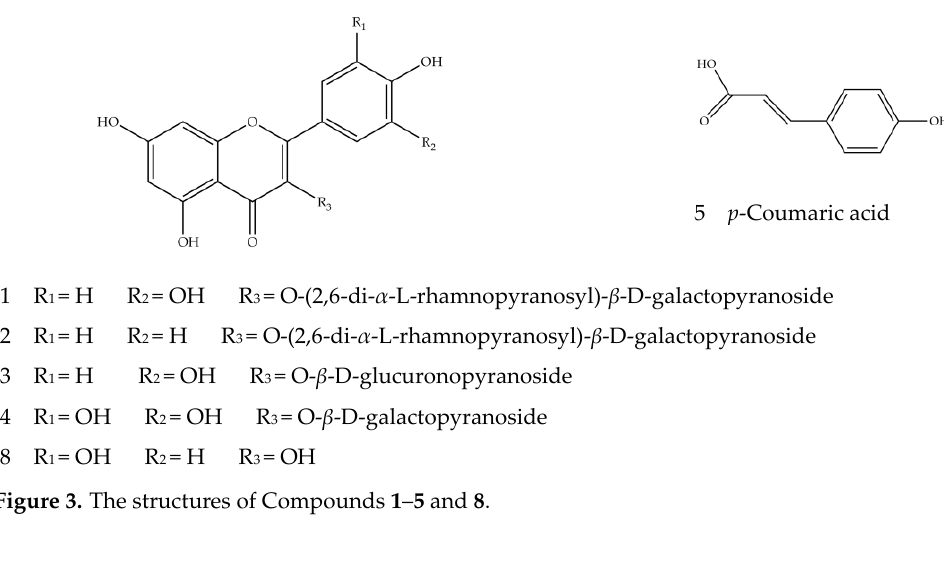
Figure 4. The structures of Compounds 6 – 7 and 9 – 23. 14 R 1 = -glcUA